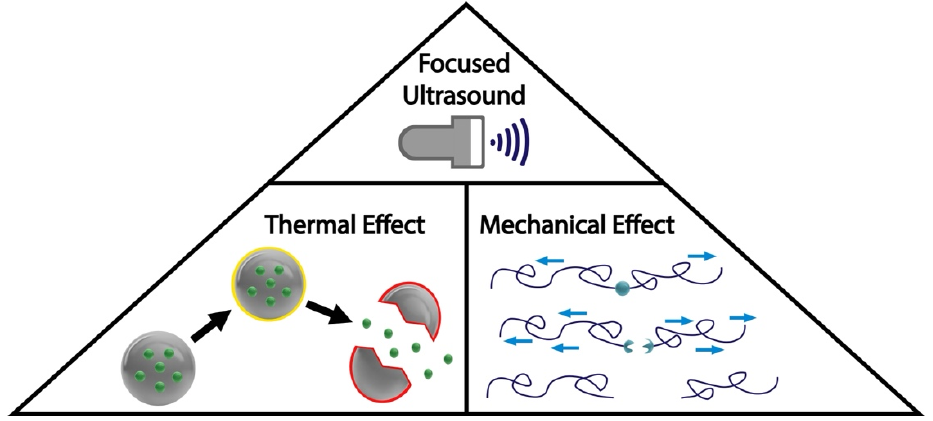
Figure 2. Mechanisms of the ultrasound response of hydrogels. Acoustic energy can be transferred either via thermal or mechanical effects.